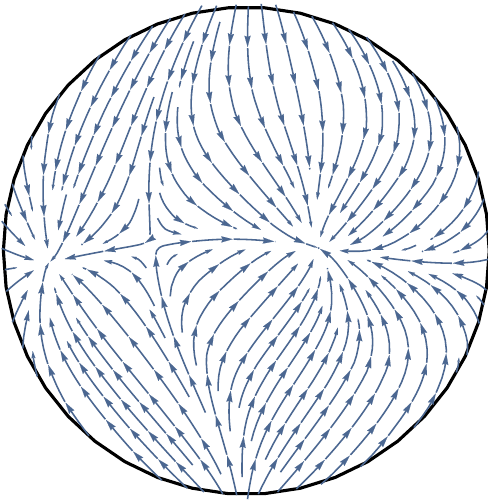
Figure 1 . The derivative d X on the